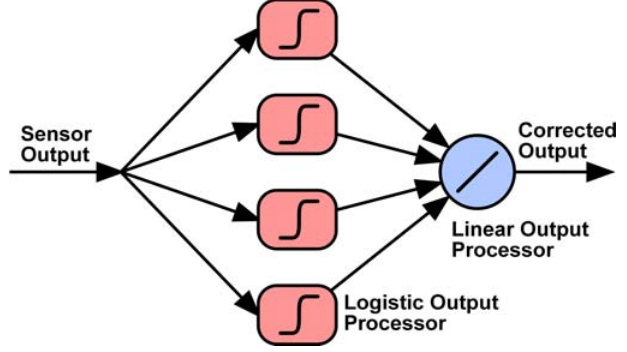
Figure 10. Sensor processing